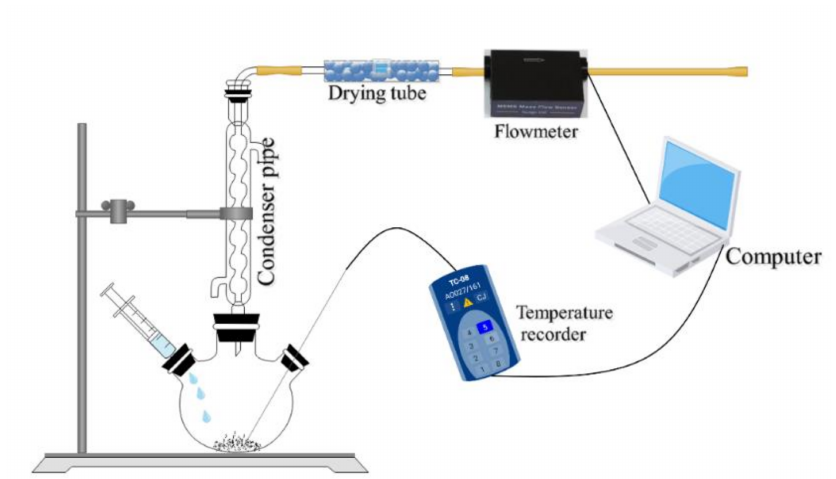
Figure 1. Schematic of the experimental installation for measuring